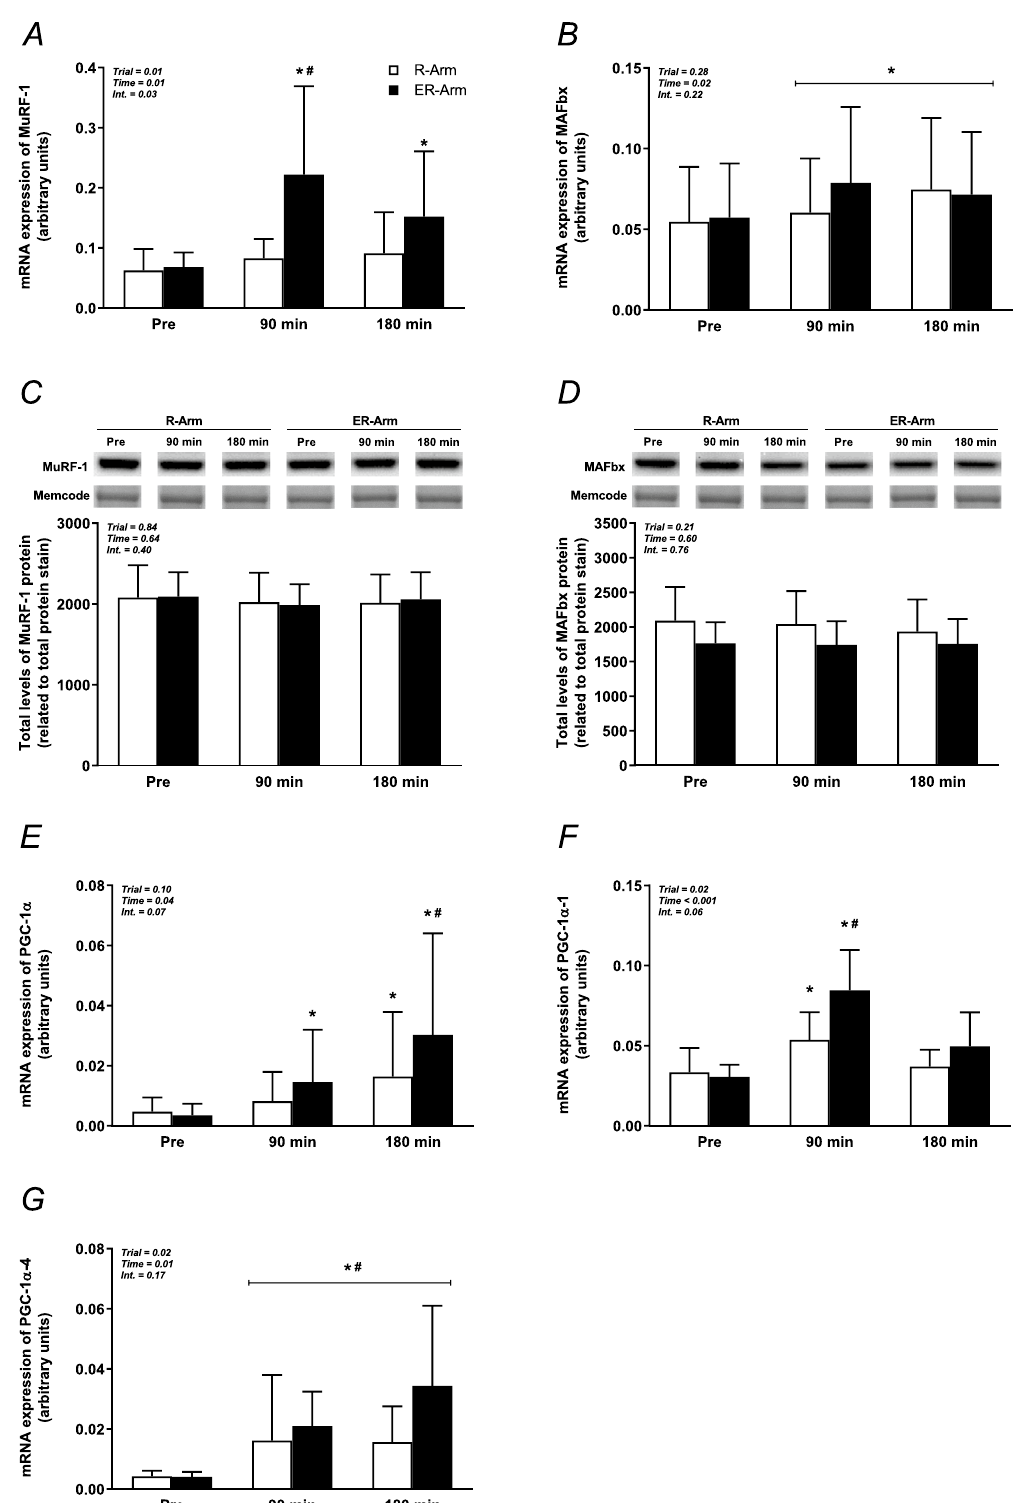
Figure 5. The levels of MuRF-1 ( A , C ) and MAFbx ( B , D ) mRNA and protein, as well as of PGC-1α1 ( E ), PGC-1α4 ( F ) and PGC-1α1 ( G ) mRNA in muscle biopsies taken at rest and following 90 and 180 min of recovery during both trials. The values presented are means ± SD for 8 subjects. * P < 0.05 vs. Rest, # P < 0.05 vs. the R-Arm trial. Symbols denoted with a line represent a main effect. Symbols without a line represent an interaction effect with corresponding significant differences in the post-hoc analysis. The mRNA levels were normalized to that of GAPDH mRNA and analyzed using the 2 −ΔCT procedure. The level of protein was related to the Memcode™ protein stain, with representative bands (from strips of full-length blots) from one subject shown above each graph. The bands have been rearranged, and separated with a white space, to fit the order of the trials in the